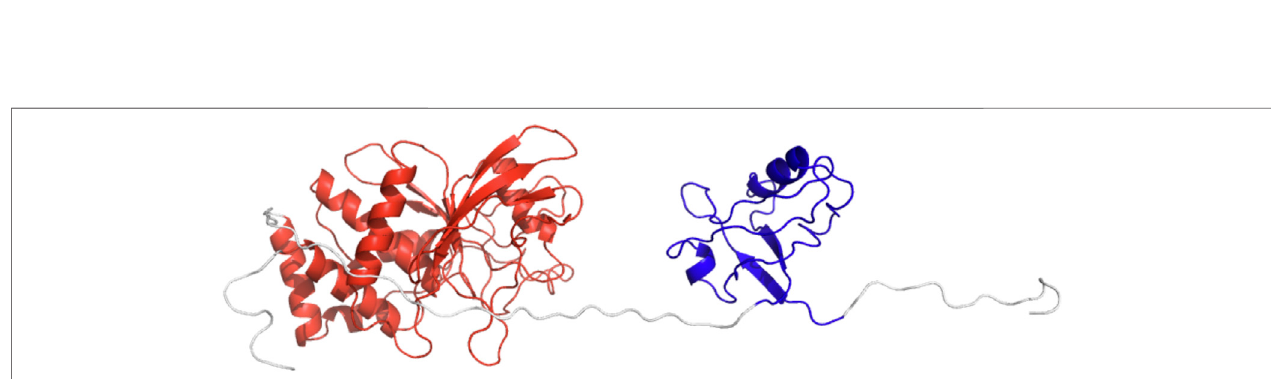
FIGURE 7 | The cartoon representation of starting conformation for the MD simulations. PDZ is colored in blue and PTP in red.